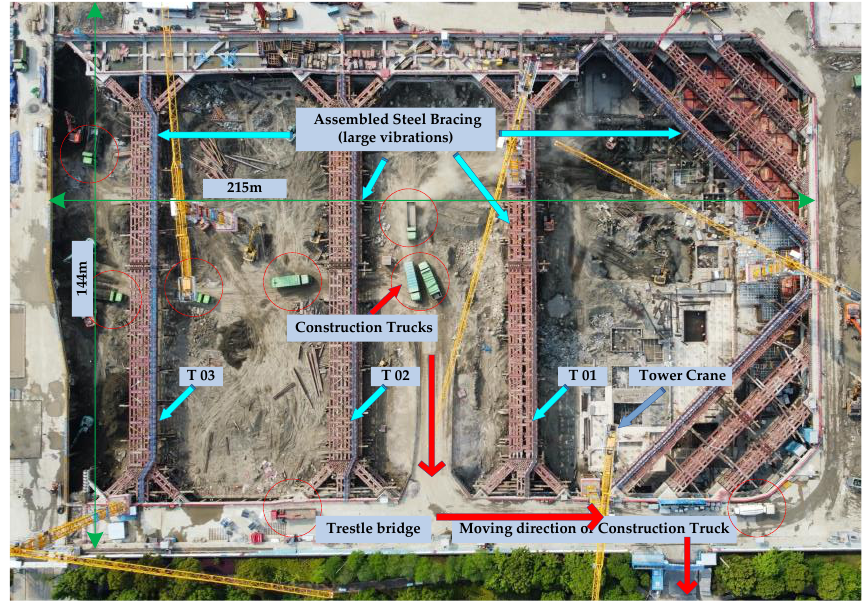
Figure 1. Steel assembly bracing of foundation pit and truck driving route. Around the foundation pit, the reinforced concrete diaphragm walls and the triaxial cement-soil mixing piles form the lateral enclosure, steel assembly bracing are used in the horizontal direction, and some reinforced concrete purlins are used as trestle bridges on the earthwork transportation path. Figure 1 shows the driving route of earthwork trucks at the foundation pit construction site and the plane layout of the steel assembly bracing. The transportation channel for the earthwork truck is closest to the steel assembly bracing T01. As can be seen from Figure 2, there are upper and lower steel assembly internal bracings along the height direction of the foundation pit, and both ends are supported on the reinforced concrete trestle bridge for earthwork truck transportation. In addition, vertical steel lattice columns are set at a certain distance in the foundation pit to provide vertical support along the length direction of the steel assembly bracing.